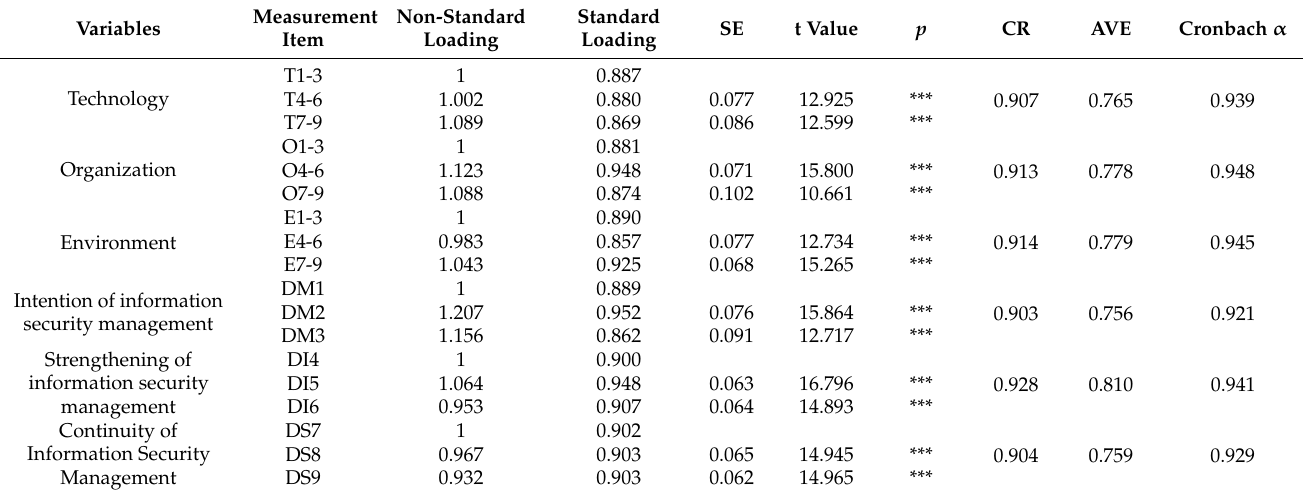
Table 3. Results of reliability and convergent validity test.